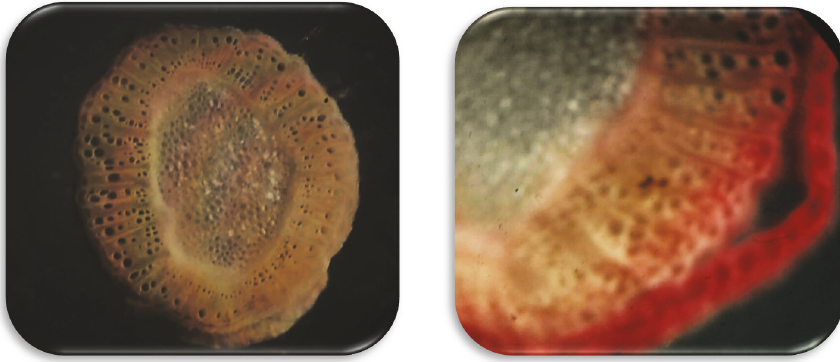
Figure 3: Anatomical structure of a Capparis spinosa stem (40X).